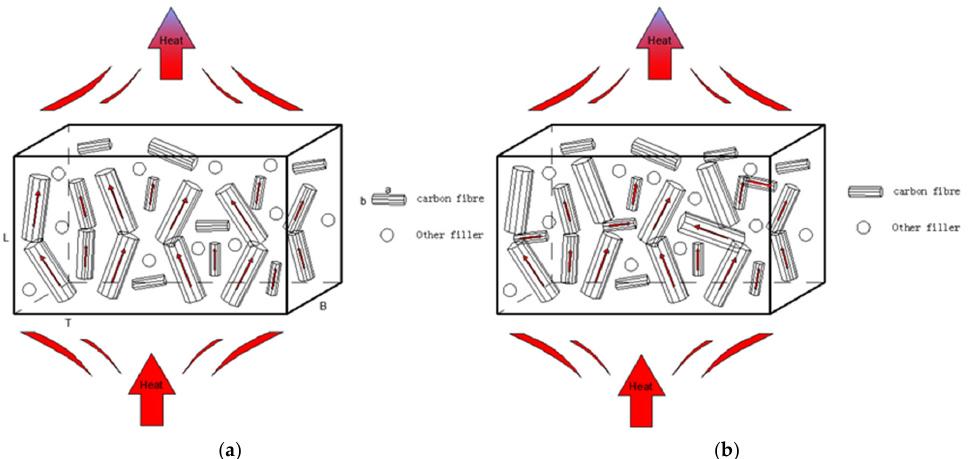
Figure 5. Schematic diagram of coating and effect of heat dissipation, ( a ) the mass fraction of CF is at critical value (red arrows represent the direction of heat transfer); ( b ) Excess CF in which L is the film thickness, T is the length, B is the width, CF parameters: Length a , diameter b (m).